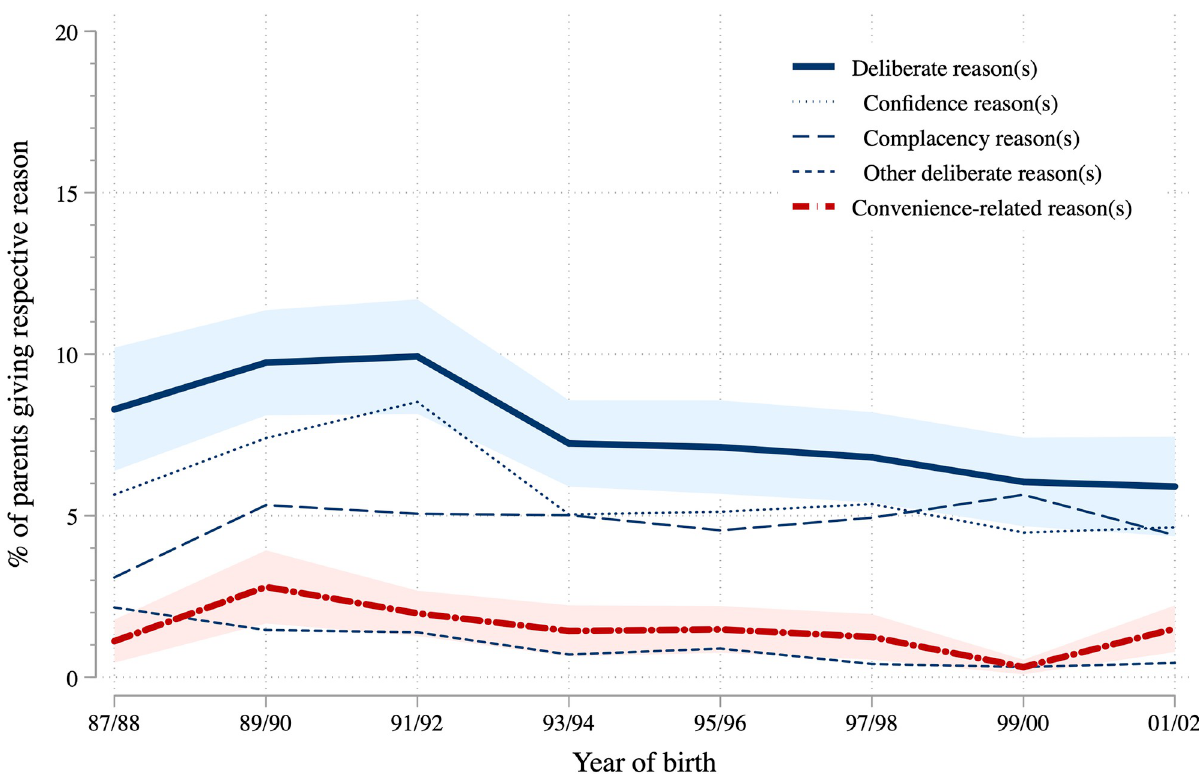
Fig 3. Reasons to not vaccinate over time. KiGGS data weighted, depending on reason between 13,517 and 13,784 observations (between 1,216 and 1,933 observations per two-year birth cohort), point estimates and 95 percent confidence